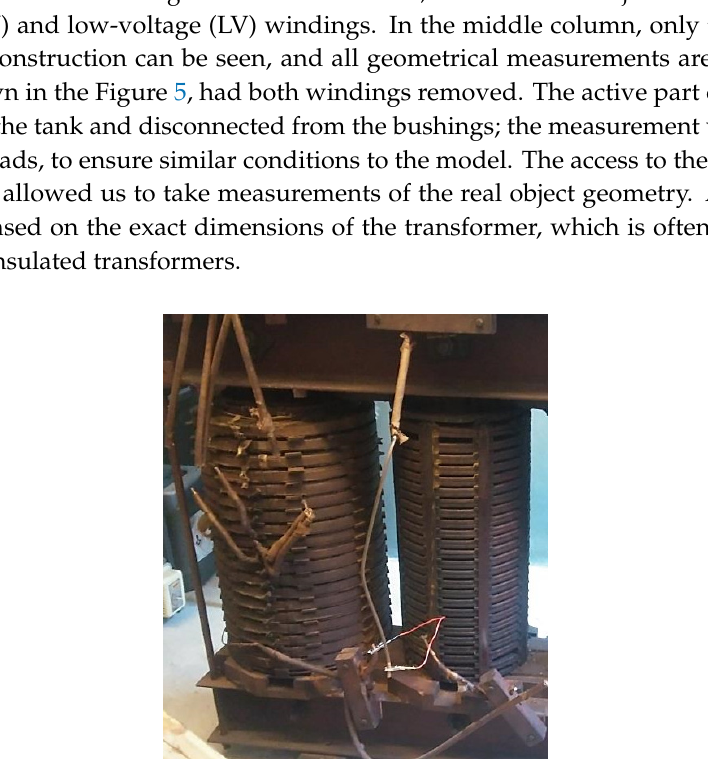
Figure 5. Windings of the tested active part of the distribution transformer.